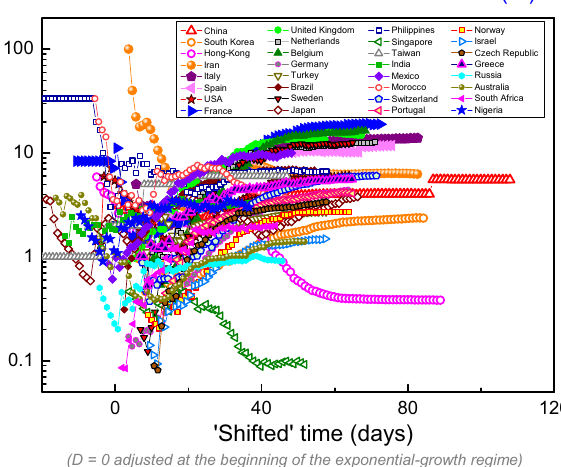
Figure 9. Ratio between cumulative deaths and con fi rmed case tolls for the selection of 32 countries considered